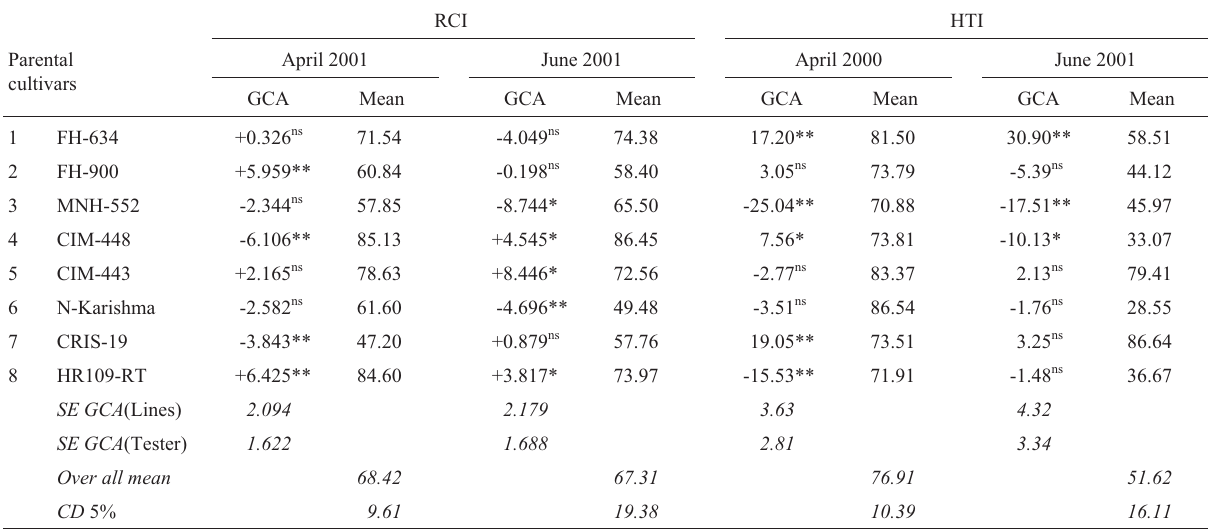
Table 4 - Estimates of general combining ability (GCA) effects for cellular membrane thermostability (CMT) as measured by relative cell injury (RCI) in April and June temperature regimes and heat tolerance index (HTI) in 2000 and 2001 crop years. RCI HTI Parental